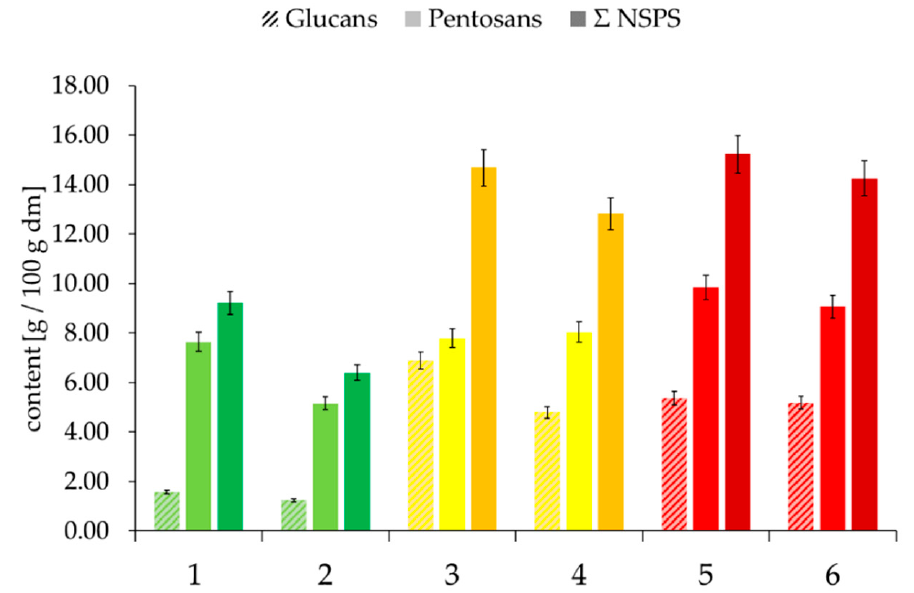
Figure 11. Content of NSPSs in the gel phases of the selected samples, depending on “good” to “medium” to “poor” baking quality and the corresponding falling number (FN) within the individual baking quality classes (here: first samples were always assigned the lower FN and second samples the higher FN). Sample description: see Table 1. Bars represent the mean value of two replicates; error bars represent the confidence interval.